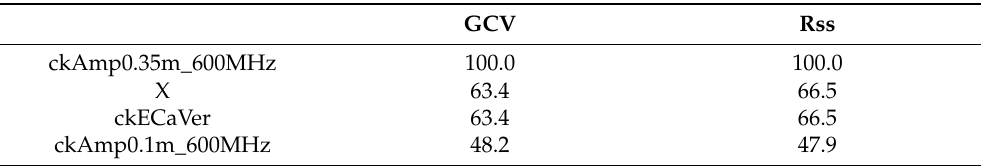
Table 11. Covariates of the MARS model listed according to their importance rank with respect to GCV (generalized cross-validation) and Rss (raw residual sum of